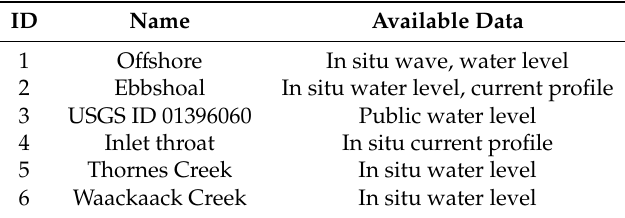
Figure 6. ( a ) Hydrodynamic modeling domain and grid configuration with (solid black line) eastern open boundary ( b ) detail in vicinity of project site. The wave modeling grid (not shown) covers the same active modeling domain and has a corresponding open boundary. Numbers denote instrument locations. See Table 3 for details. Table 3. Sources of water levels, current profiles, and wave observations.